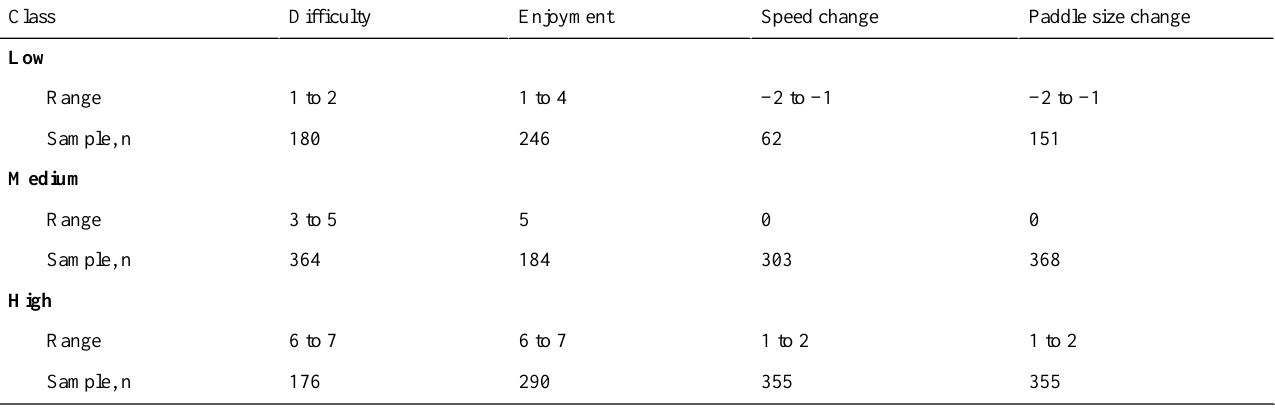
Table 1. Defined ranges for retraining the three-class